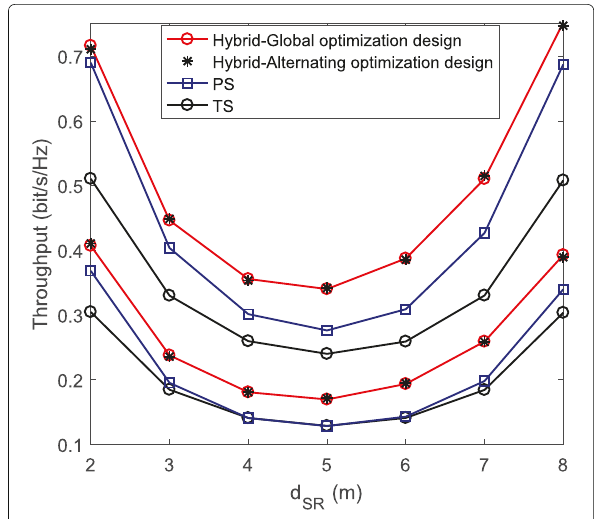
Fig. 9 Throughput performance of different protocols versus d SR , SNR =